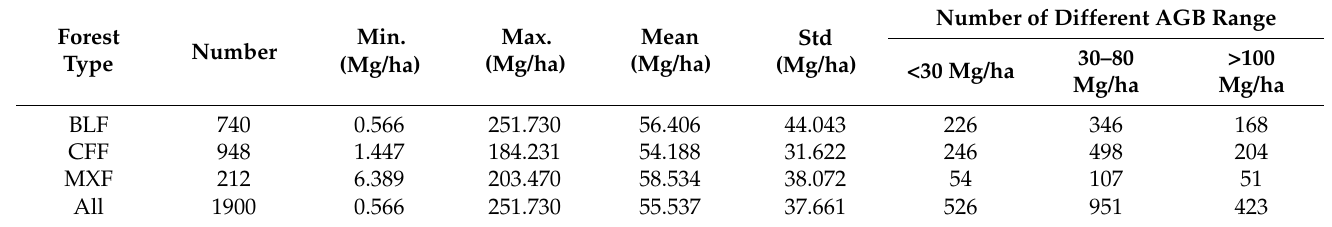
Table 1. AGB statistics of sample plots.